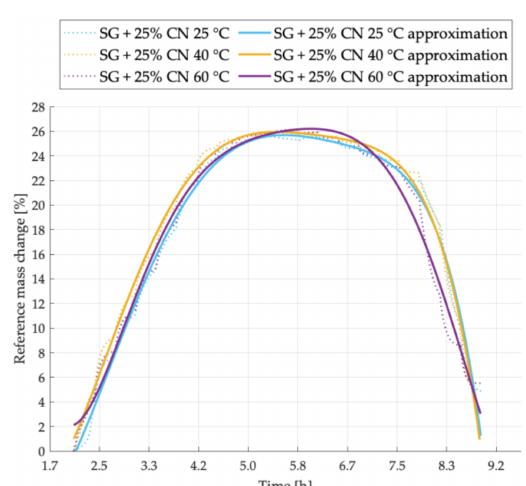
Figure 6. Sorption kinetics graph for SG + 15% CNT sample tested at temperatures of 25 ◦ C, 40 ◦ C, 60 ◦ C.